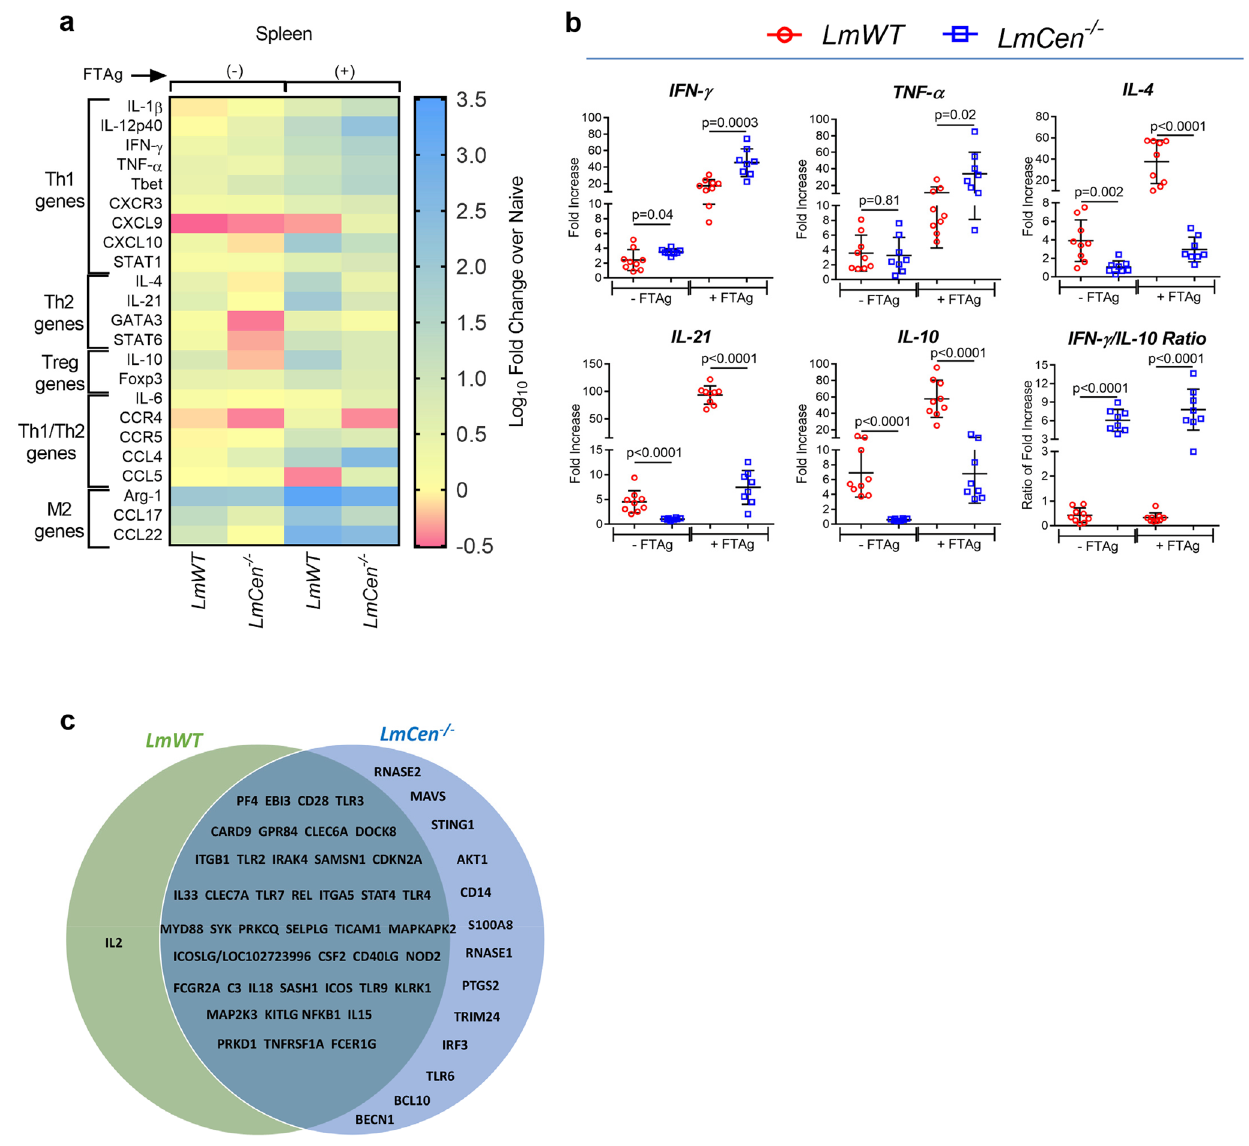
Fig. 2 Immunogenicity of LmCen - − / − parasites in hamsters. a Heat map showing the differential gene expression in the spleen (with or without 24 h of L. major freeze – thaw antigen restimulation; ±FTAg) of LmWT infected and LmCen -/- immunized hamsters at 7 weeks post inoculation. Downregulation and upregulation of the transcripts are shown in blue, yellow and pink respectively. Transcripts are annotated in the left side according to their general functions. For heat map, results were shown as log 10 fold change over naive hamster. b Expression pro fi le of IFN- γ , TNF- α , IL-4, IL-21, IL-10, and IFN- γ /IL-10 Ratio in the spleen which was evaluated by RT-PCR. The expression levels of genes of interest were determined by the 2 − ΔΔ Ct method; samples were normalized to either γ -actin expression or 18S RNA and determined relative to expression values from naive hamsters. The results were pooled of two independent experiments. Results (Mean ± SD) represent cumulative effect of two independent experiments ( n = 4 for Naive, n = 9 for LmWT , and n = 8 for LmCen − / − ) ( p values were determined by Mann – Whitney two-tailed test). c Ingenuity pathway analysis comparing the expression of the immune markers in LmWT and LmCen − / − groups showing upstream regulators as predicted by the IPA is shown. Most upstream regulators are shared between the LmWT and LmCen − / − infections as shown in the area of intersection. The statistical analysis is provided in Supplementary